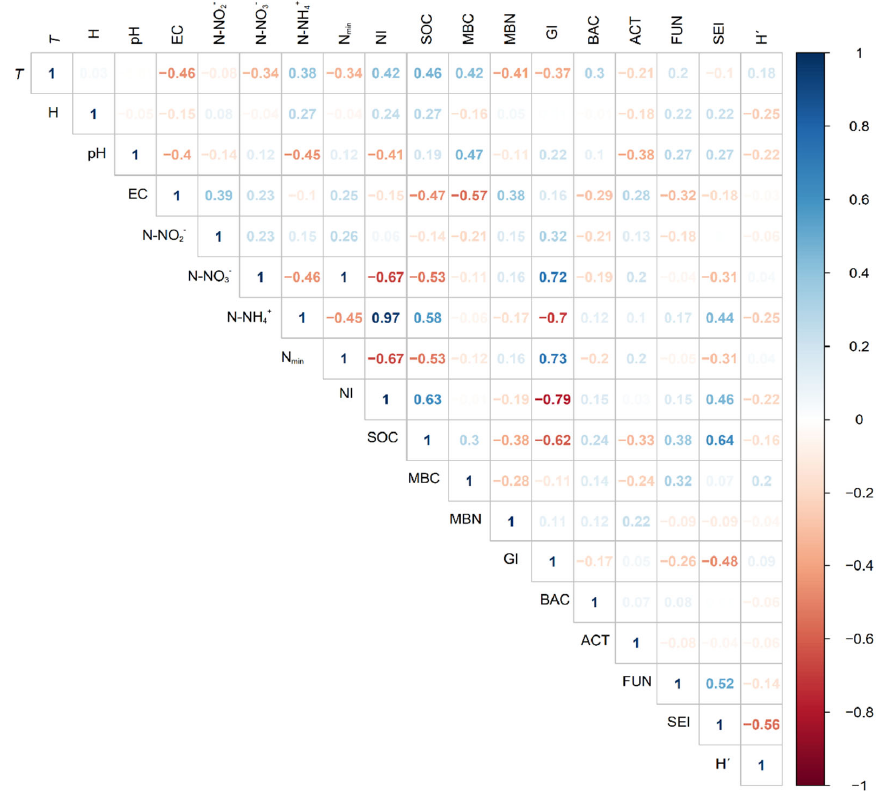
Figure 6. Pearson’s product-moment correlation matrix. Positive correlation in blue, negative in red, Figure 6. Pearson ʹ s product ‐ moment correlation matrix. Positive correlation in blue, negative in red, no correlation not shown. no correlation not shown.